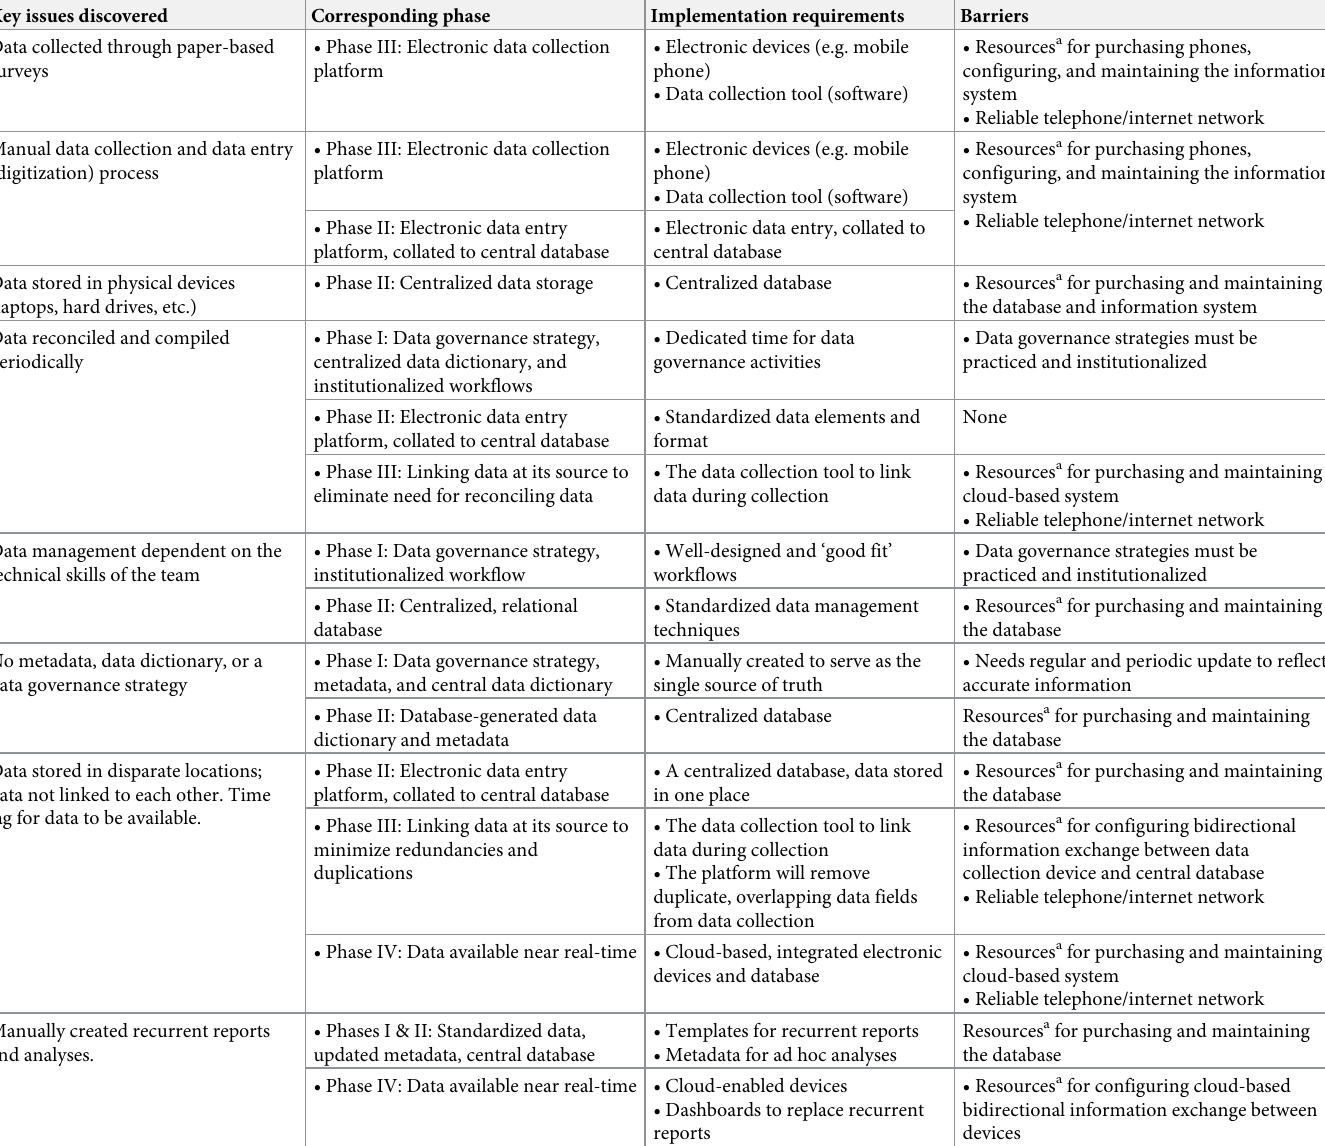
Table 4. Key issues facing the Chad Guinea Worm Eradication Program information system, how these were addressed, and potential challenges. Key issues